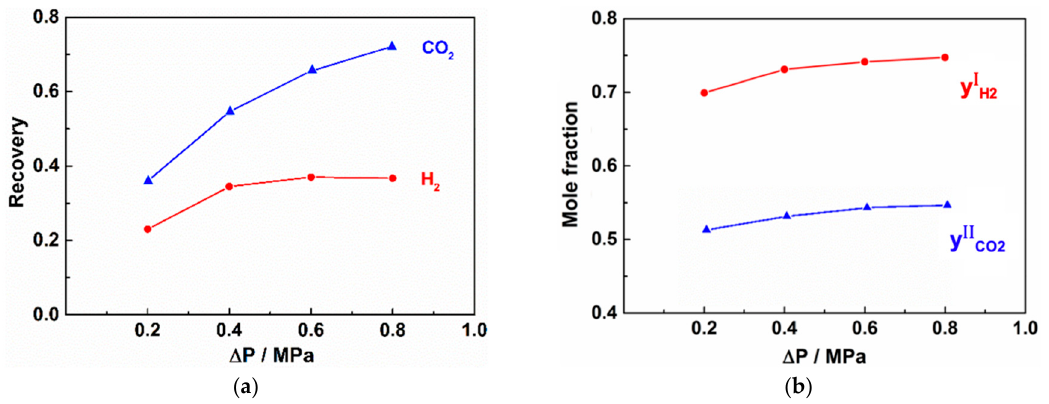
Figure 8. Effects of operating pressure on the purity and recovery of the dual membrane separator. ( a ) The recovery of H 2 and CO 2 ; ( b ) the purity of H 2 and CO 2 .